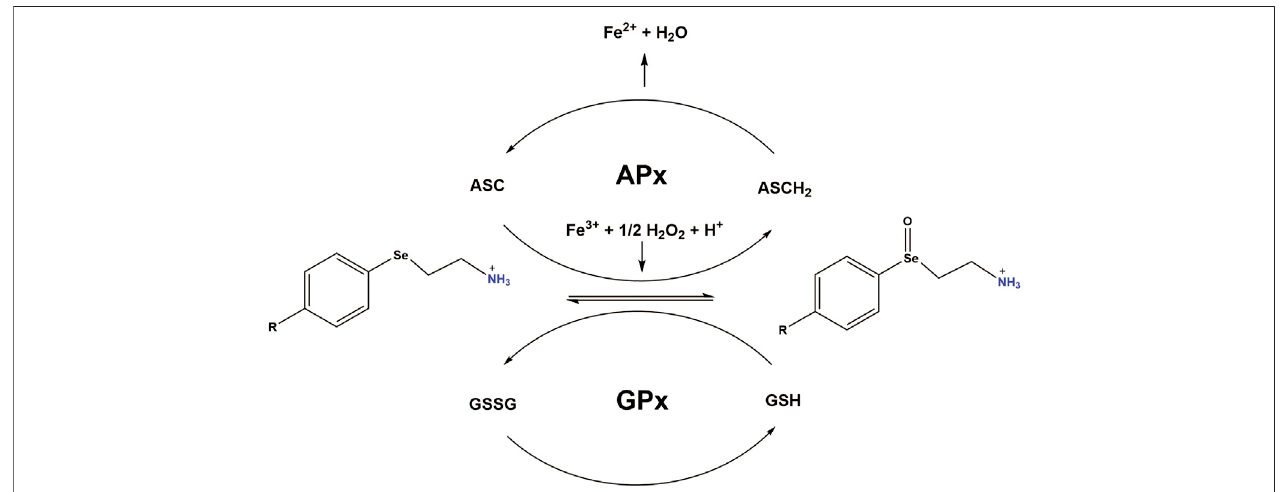
FIGURE7| Workingmodel:PAESeisoxidizedtoitsselenoxidePAESe(O)formviadopamine- β -monooxygenase.ReducedAscorbate(ASCH 2 )reducesPAESe(O) back to the reduced form generating oxidized ascorbate (ASC) in the process. ASC is then capable of reacting with PAESe and hydrogen peroxide to reduce Fe 3+ back to Fe 2+ . Catalytic regeneration of PAESe is also enhanced via Glutathione Peroxidase (GPx) reduction with glutathione (GSH), yielding glutathione disul fi de (GSSG). Regeneration of PAESe enables mitochondrial ROS formation to be ameliorated at a much faster rate compared to normal physiological conditions, allowing for potent free radical scavenging and enhanced mitochondrial function. The working model is adapted from a fi gure by May et al. (May and Pollock, 1998).